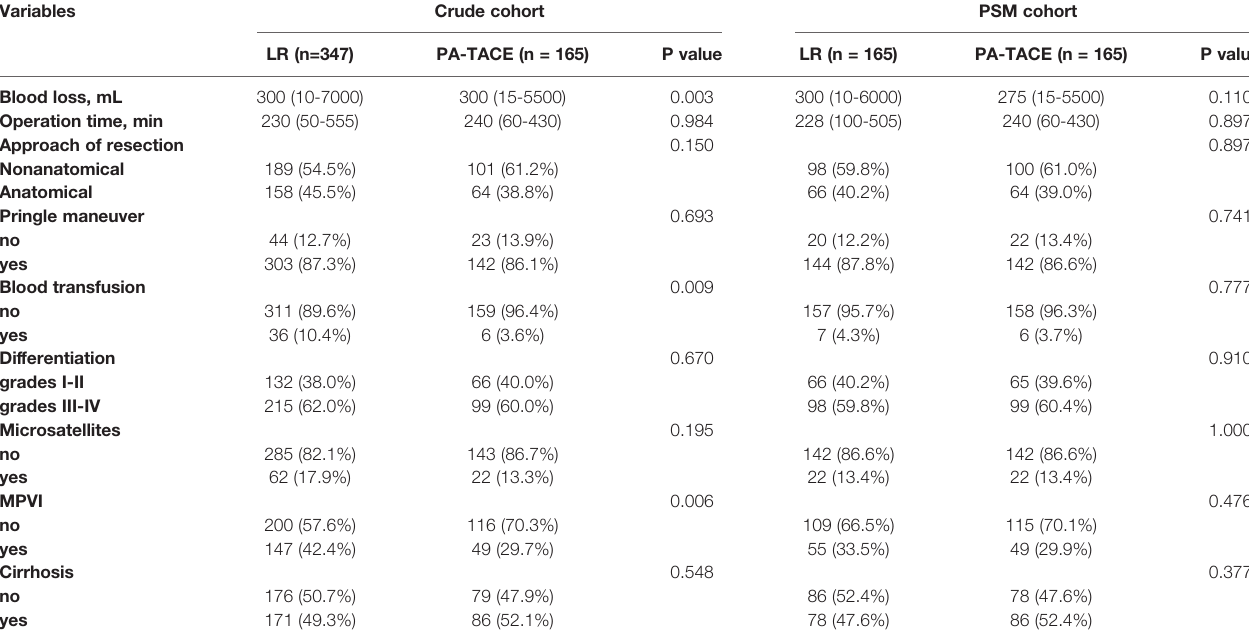
TABLE 2 | Surgical and pathological data of all patients strati fi ed by treatment. Variables Crude cohort